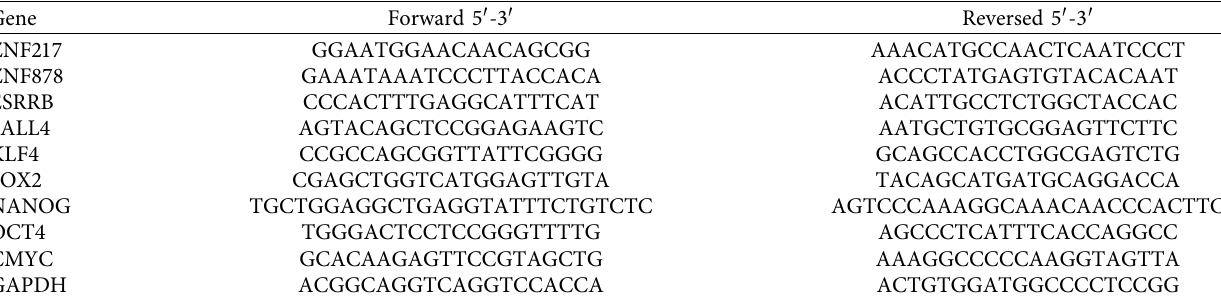
Table 2: Primer design for Q-RTPCR (forward 5 ′ -3 and reversed 5 ′ -3 ′ sequences for molecular analysis). Gene Forward 5 ′ -3